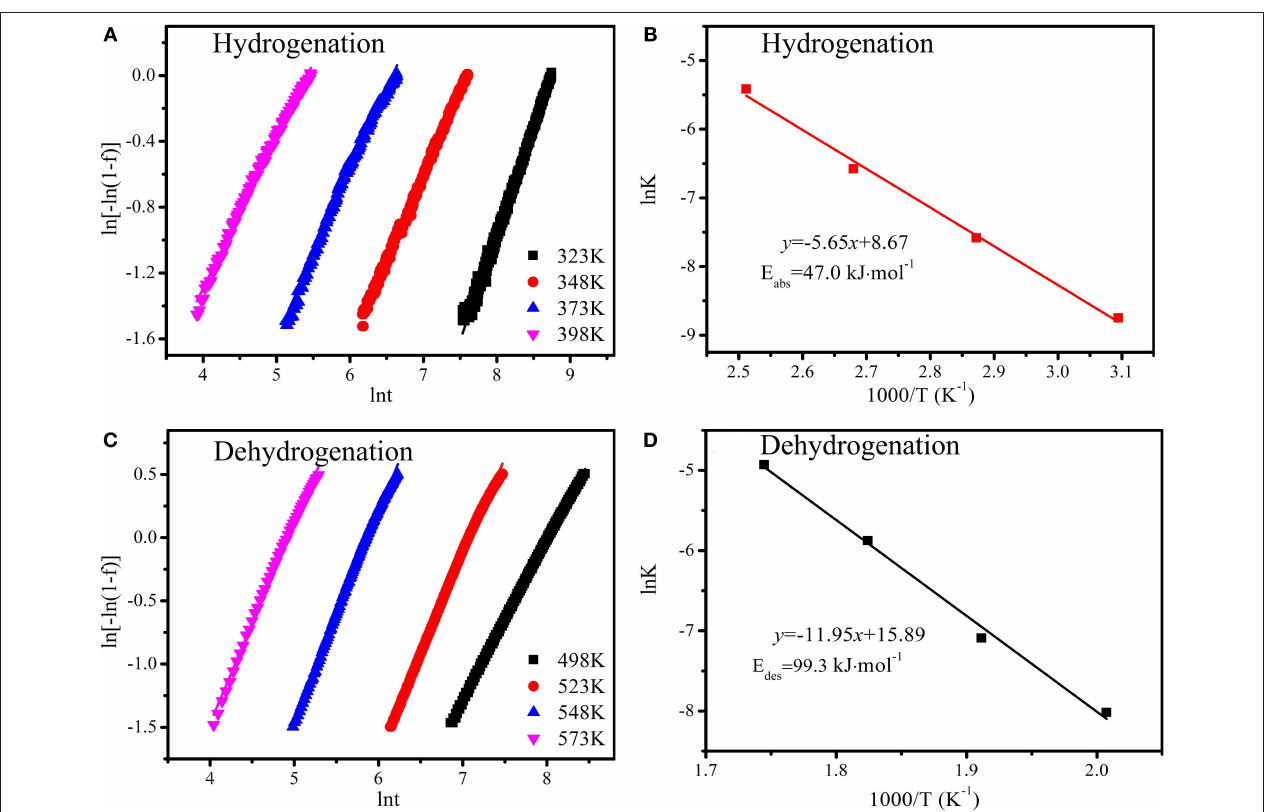
FIGURE 8 | Plot of ln[-ln(1- f ( t ))] vs. ln t curves (A,C) and Arrhenius plots (B,D) for the Mg-(Ni-TiO 2 )@rGO composite: (A,B) hydrogenation; (C,D)